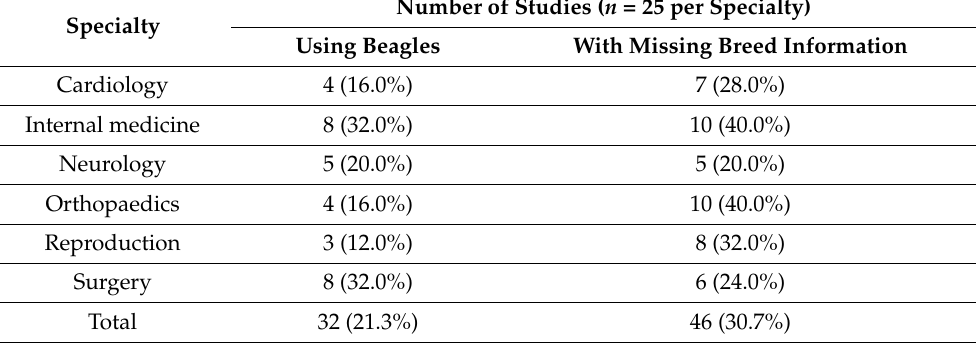
Table 2. Use of Beagles as trial dogs within six veterinary specialties in 150 clinical trials (25 per